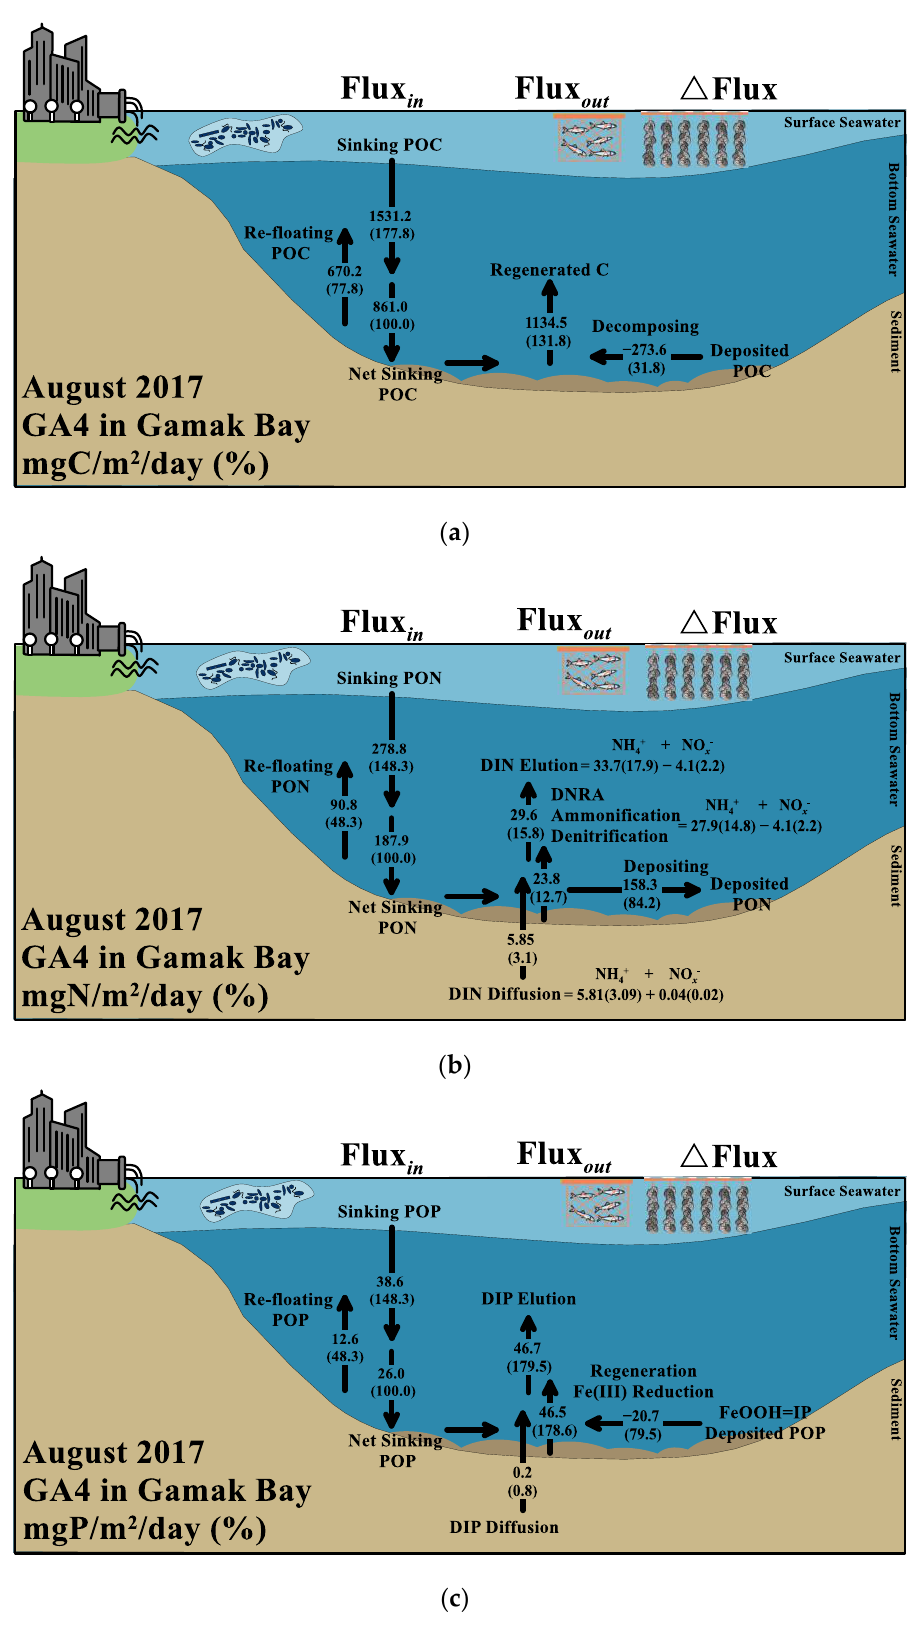
Figure 9. The illustrations of mass balances based on the simple model (Flux in = Flux out + ∆ Flux) for GA4, Gamak Bay, Korea, August 2017: ( a ) Carbon (C); ( b ) Nitrogen (N); ( c ) Phosphorus (P). Net sinking POC flux (861.0 mg C/m 2 /d) differed from organic carbon Flux out (1134.5 mg C/m 2 /d), estimated using SOD T flux. The additional flux of 273.5 mg C/m 2 /d (31.8% of the organic carbon Flux out ) acted as the decomposition from the surface sediments to the